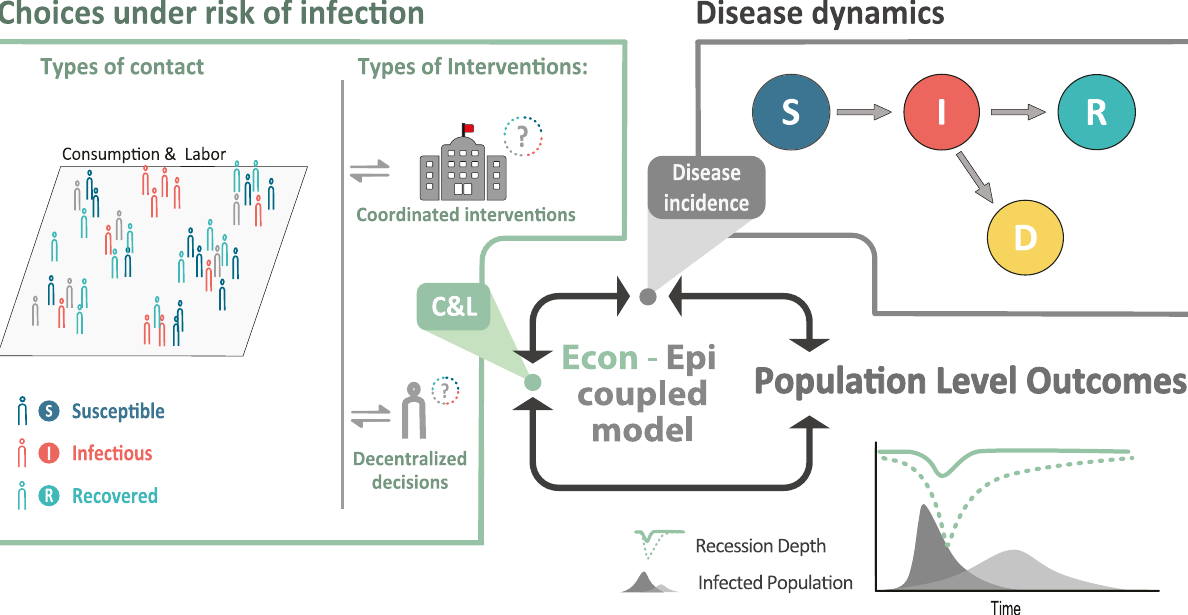
Fig. 1 Coupled system schematic. Individuals make consumption ( C ) and labor-leisure ( L ) choices, considering the risk of infection through contacts with others. Individual choices and resulting contacts affect and are affected by the disease dynamics. Individual economic choices drive population-level outcomes such as disease prevalence and economic recessions. Under decentralized approaches, individuals optimize their behaviors based on their own preferences and health status. Under coordinated approaches, individuals' behaviors are optimized based on how they affect population-level